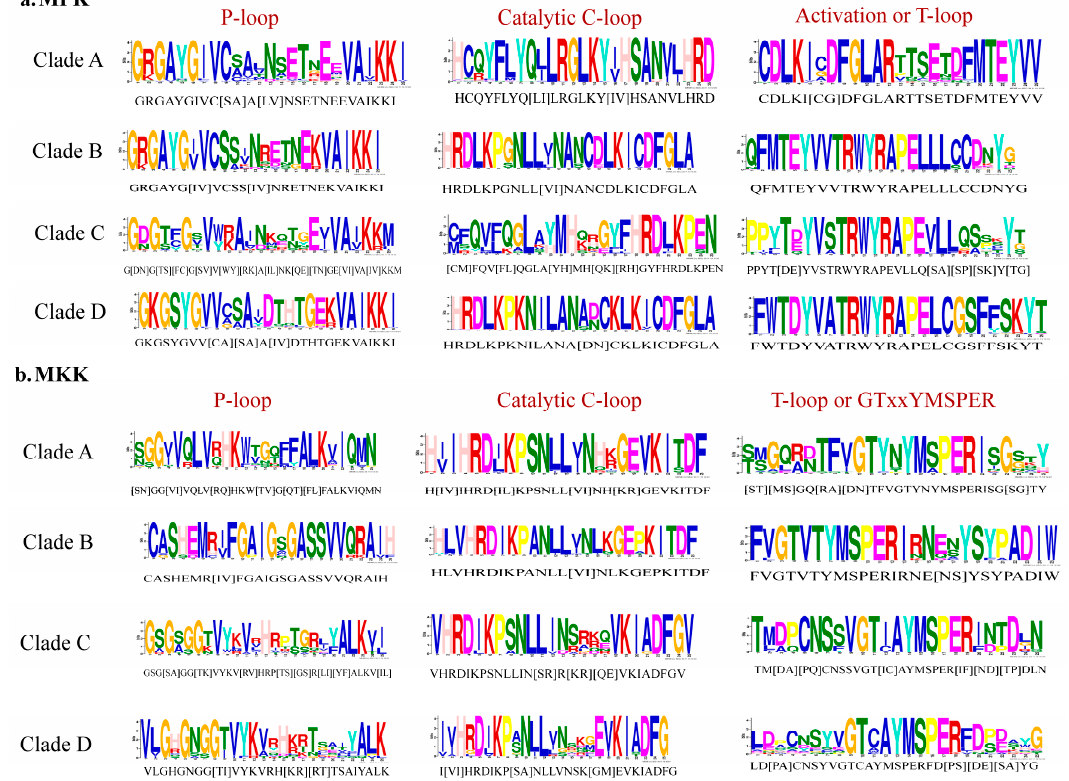
Figure 4. P-loop, catalytic C-loop, and activation or T-loop motifs representing variations in Clades A–D. ( a ) MPK; ( b ) MKK.